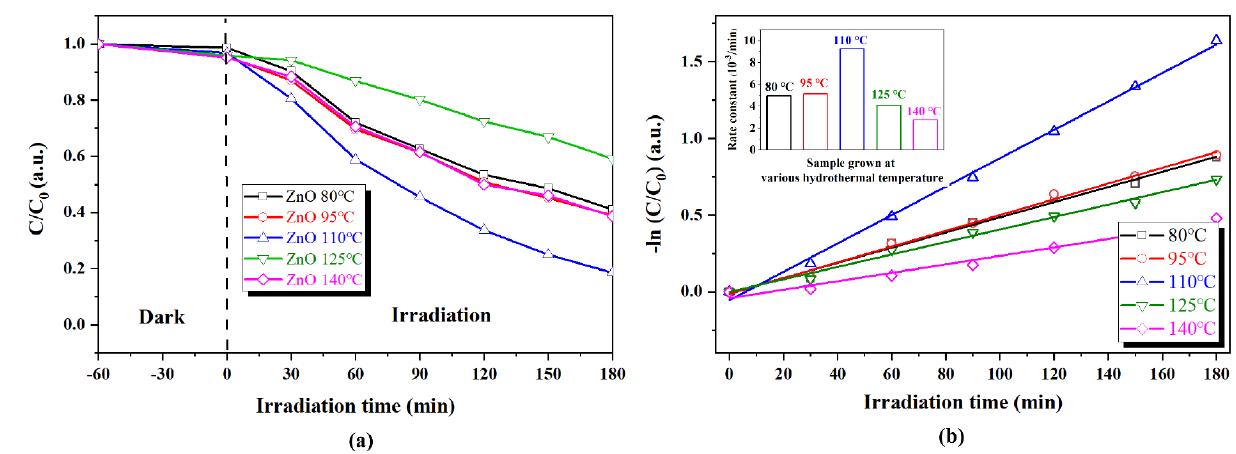
Figure 6. ( a ) RhB concentration changes over nanosheet arrays grown at various hydrothermal temperatures as a function of irradiation time ( b ) Pseudo-first-order kinetic fitting plots. The inset is photodegradation rate constant comparison.